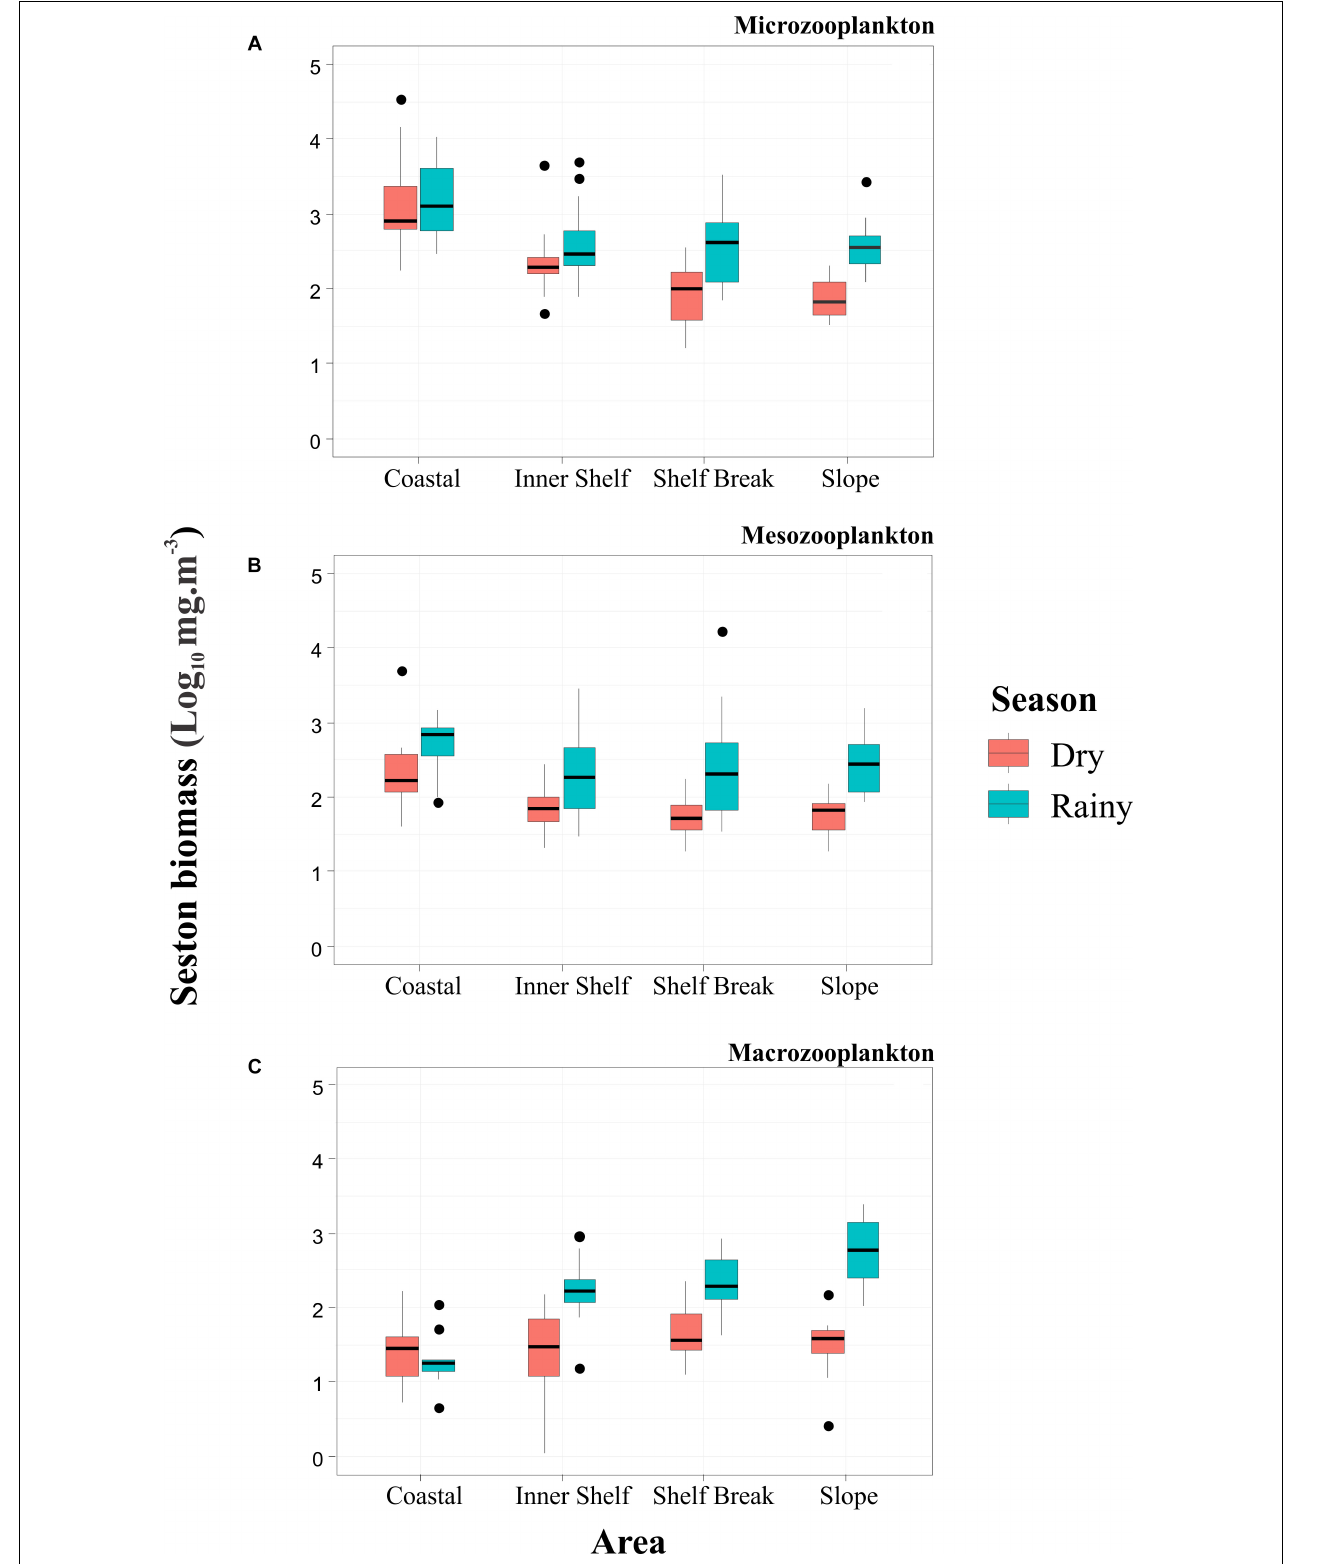
FIGURE 5 | Box-plot of seston biomass (Log 10 mg · m − 3 ) of microzooplankton (A) , mesozooplankton (B) , and macrozooplankton (C) at the coastal and oceanic areas off Rio Grande do Norte, Southwestern Atlantic. Dots = outliers.